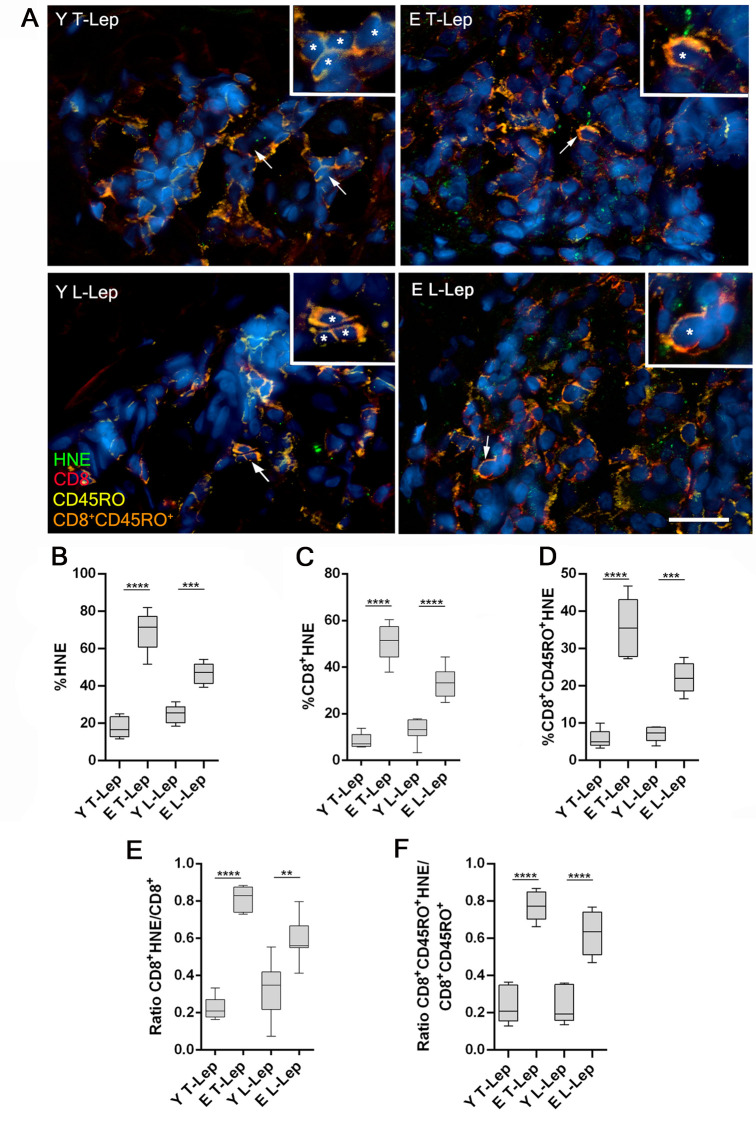
Analysis of oxidative stress by quantifying 4-hydroxynonenal in skin lesions of leprosy patients.Immunofluorescence assays were performed to determine the number of memory CD8+ T cells (CD8+CD45RO+) associated with 4-hydroxynonenal (HNE) signal, as well as HNE abundance in tissue. (A) Representative images of skin lesions from a young paucibacillary patient (Y T-Lep), an elderly paucibacillary patient (E T-Lep), a young multibacillary patient (Y L-Lep) and an elderly multibacillary patient (E L-Lep), presenting HNE (green, Alexa Fluor 488), CD8 (red, Alexa Fluor 594), CD45RO (yellow, Alexa Fluor 633) and nuclei stained by DAPI (blue). Arrows and asterisks indicate CD8+CD45RO+ cells, stained in orange. In the enlarged inserts, more intense HNE signal in elderly T-Lep and L-Lep patients is observed. Scale bar represents 40μm in main image and 20 μm in inserts. The graphs present frequency of (B) HNE-associated cells, (C) double-positive CD8+HNE-associated cells, (D) triple-positive CD8+CD45RO+HNE-associated cells (E) ratio between frequency of CD8+HNE-associated cells and total CD8+ cells and (F) ratio between frequency of CD8+CD45RO+HNE-associated cells and CD8+CD45RO+. Results are reported as percentage of positive cells in interquartiles (minimum to maximum) in groups of 4 patients. These data were compared using one-way ANOVA followed by Tukey’s multiple comparisions test. **P < 0.005, ***P < 0. 001 and ****P < 0.0001.